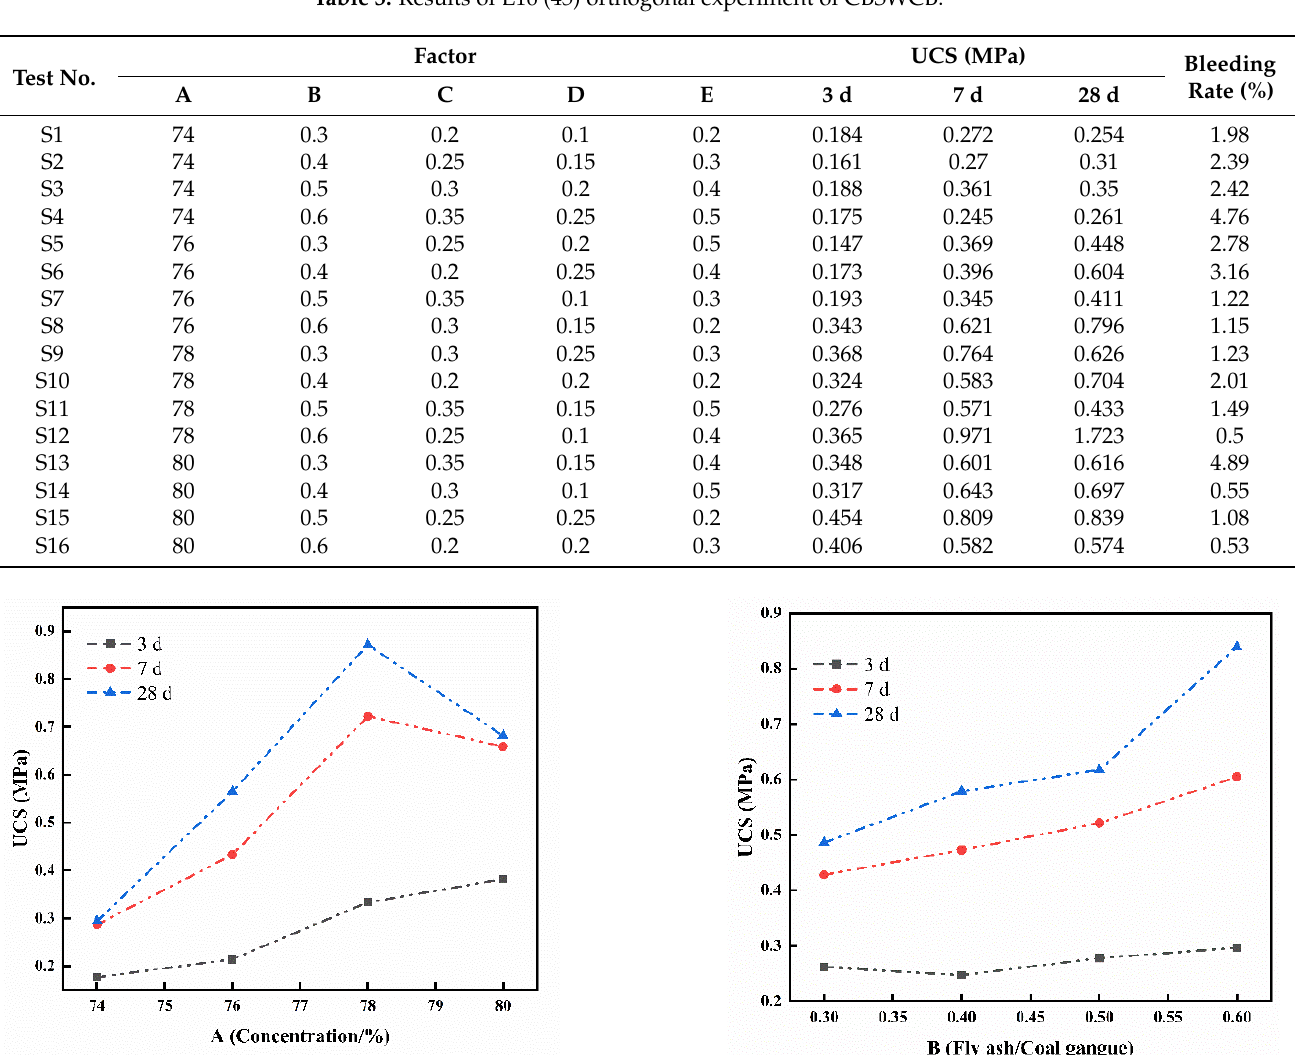
Table 3. Results of L16 (45) orthogonal experiment of CBSWCB.